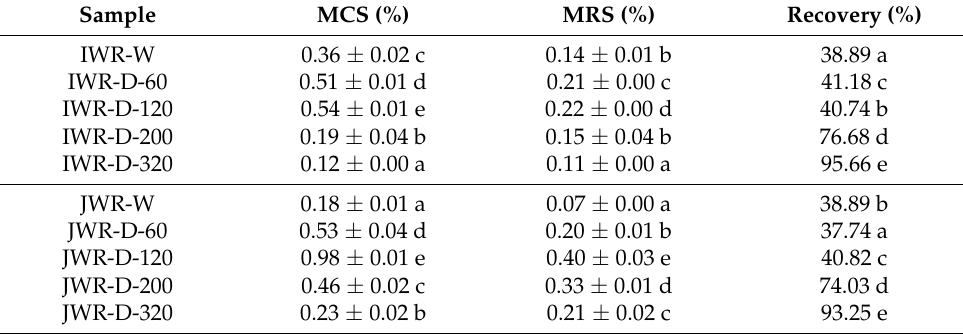
Figure 4. The viscoelastic properties of waxy rice flour. ( a ) and ( c ) stand for the storage moduli (G’) of IWR and JWR, respectively. ( b ) and ( d ) stand for the loss moduli (G’’) of IWR and JWR, respectively. Table 3. Fitting parameters of creep characteristics of waxy rice Table 2. Fitting parameters of viscoelastic properties of waxy rice flour.